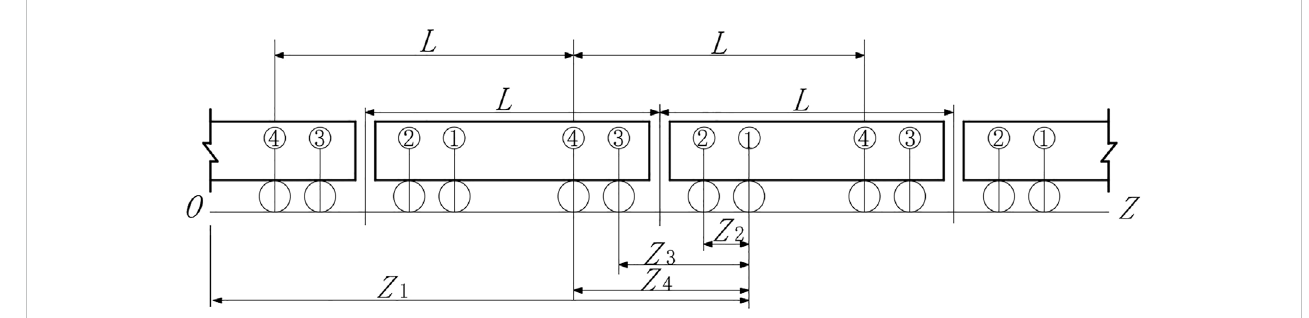
FIGURE 2 Diagram of separation and combination of vehicle loads.